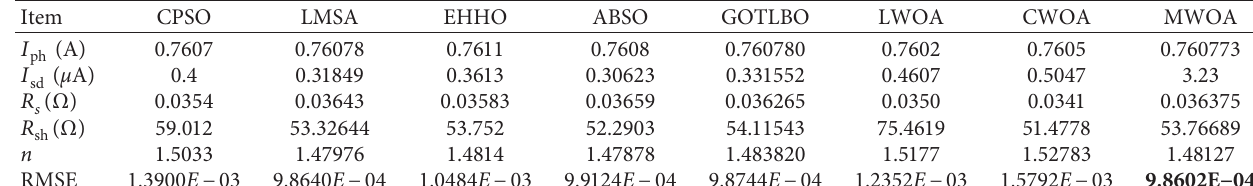
Table 2: Identification results of SDM based on seven algorithms.